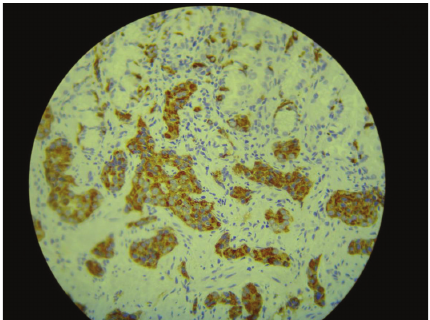
Figure 3: Immunohistochemistry exam positive for chromogranin A.